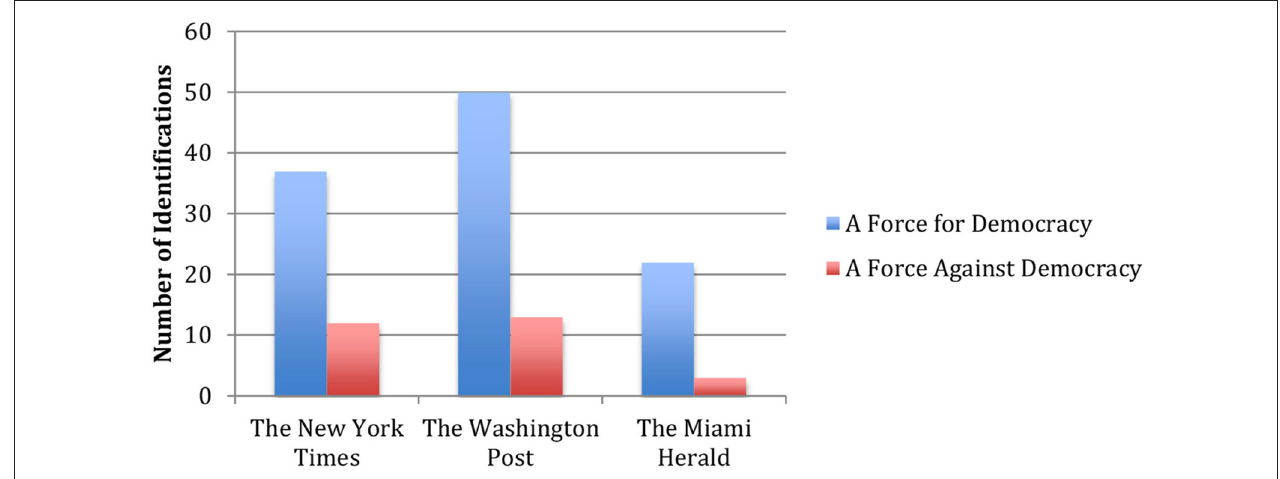
FIGURE 1 | The US: A Force for Democracy? 2002 Newspaper